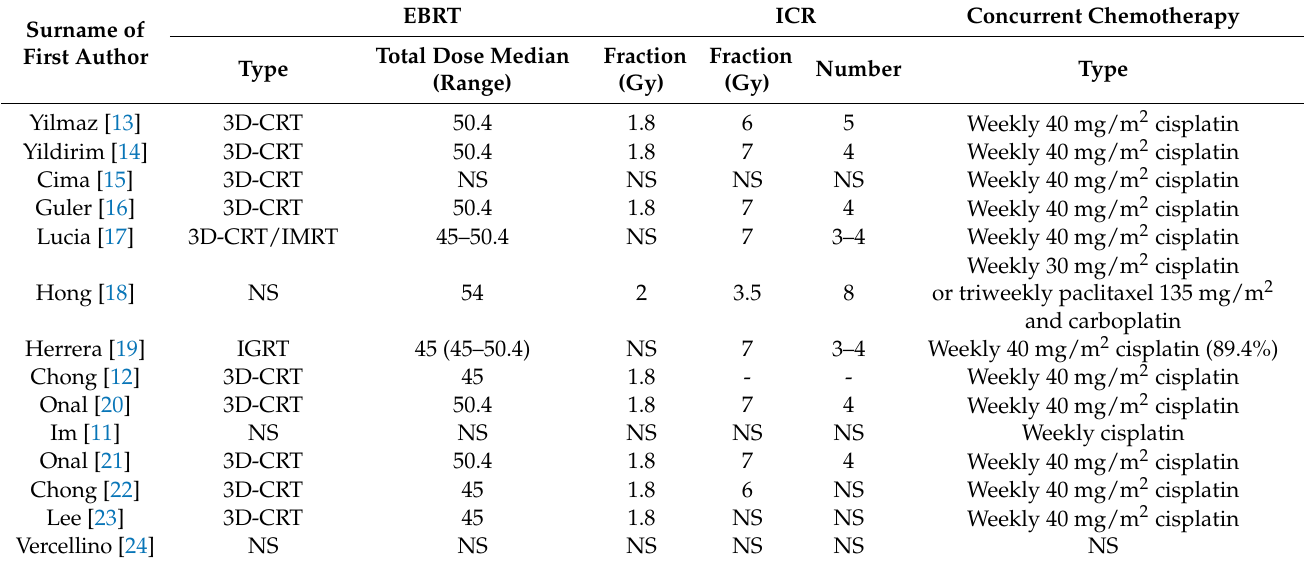
Table 3. Treatment-related